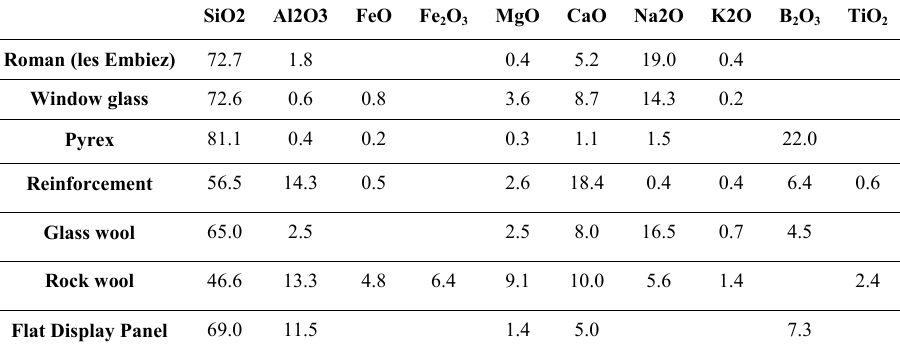
Table 1: Compositions of a few glasses in wt % [3, ch. 1]. For Flat display panel glass, add 4.4 % BaO, 1.2 % SrO and 0.3 % Sb 2 O 3 .